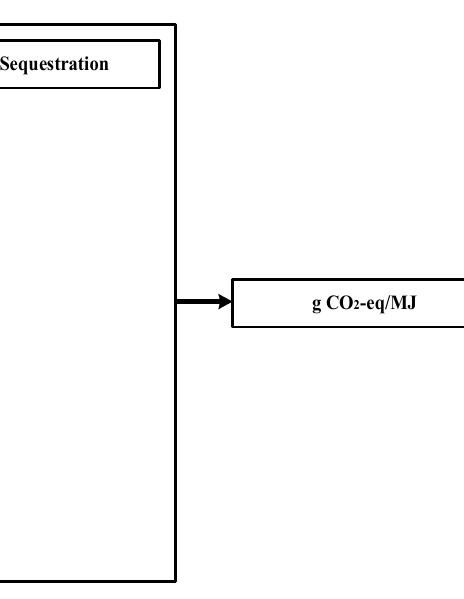
Figure 3. The system boundary of the LCA process.